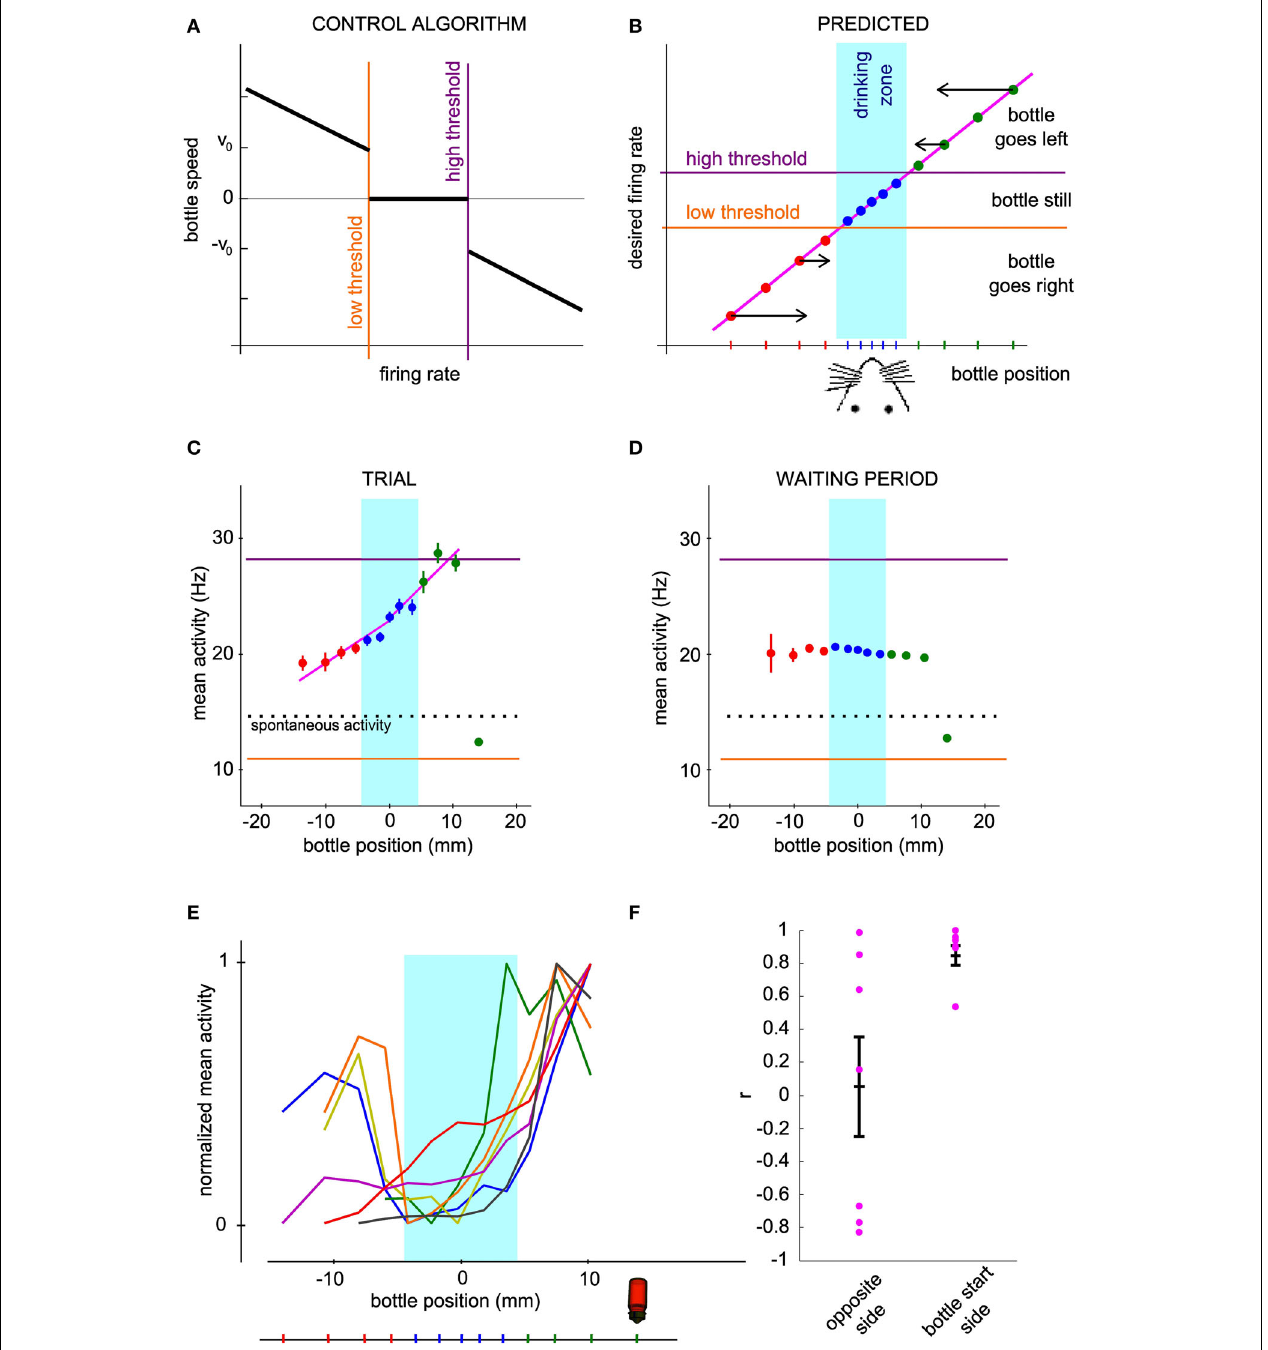
FIGURE 4 | The mean neuronal activity encodes bottle position. (A) Control algorithm giving the bottle speed and direction of movement as a function of the neuronal activity relative to the low and high thresholds. (B) Predicted relation between neuronal activity and bottle position for successful operant conditioning. The arrows qualitatively show the optimal direction and speed of the bottle for each bottle position, converging to the rat mouth. The vertical location of the points is thus determined by the firing rate required to produce the desired bottle speed according to the control algorithm of panel (A) . (C) Mean and s.e.m. firing rate of a conditioned neuron during all trials of one session as a function of bottle position. The dotted line indicates